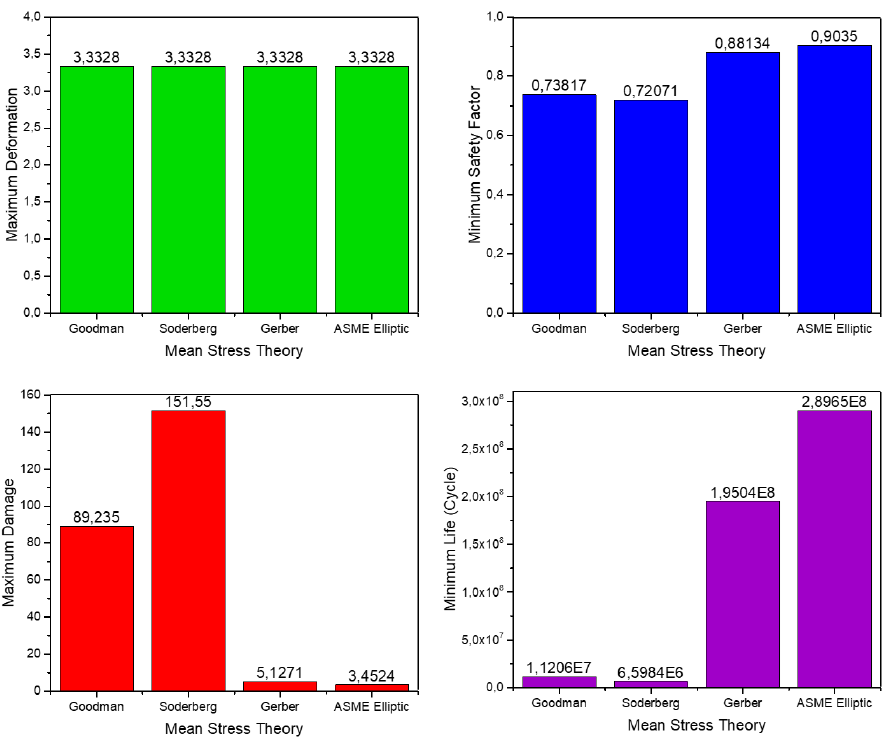
Figure 27. Fatigue Results: Maximum Deformation, Minimum Safety Factor, Maximum Damage, and Minimum Figure 27: Fatigue results: Maximum deformation, minimum safety factor, maximum damage, and minimum life for each mean stress theory Life for Each Mean Stress Theory Used